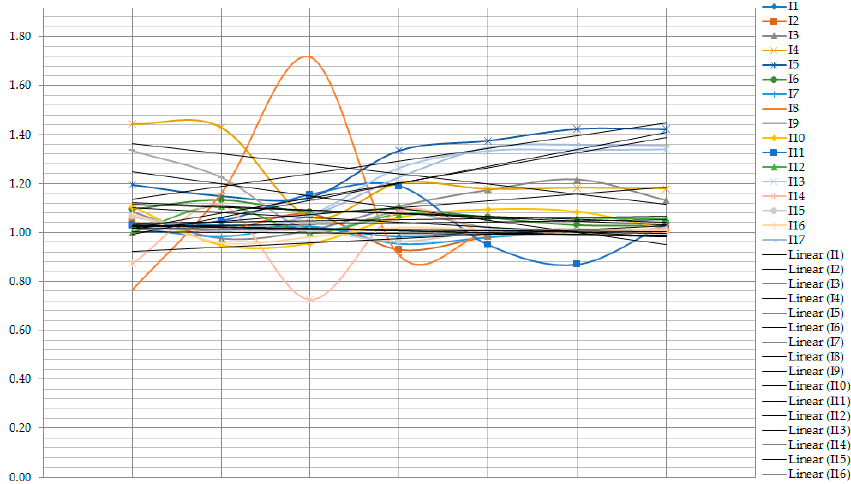
Figure 4. Frontier index.